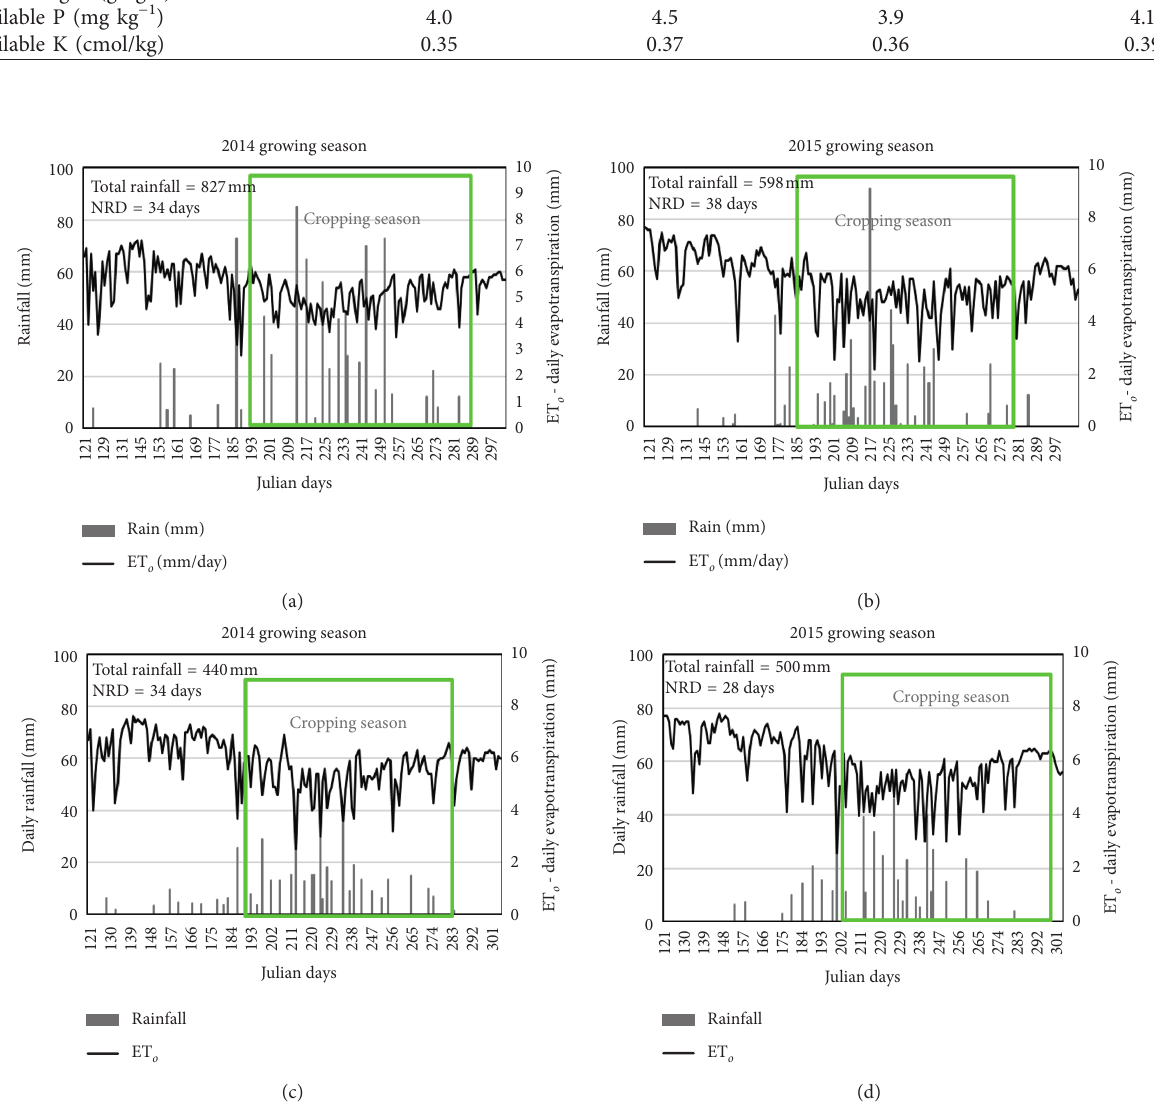
o ) during 2014 and 2015 growing seasons: (a, b) Minjibir and (c, d)